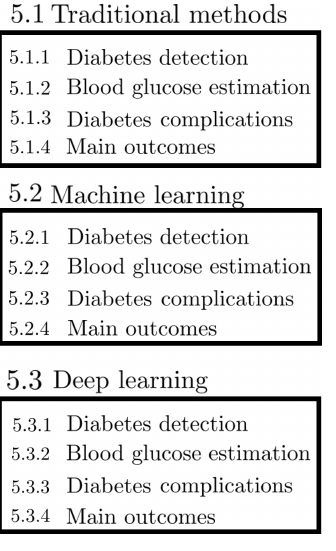
Figure 6. Graphic representation of this section